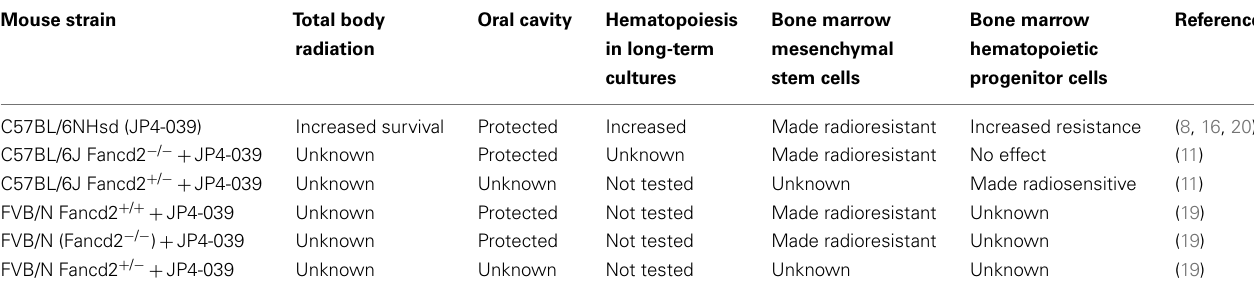
Table 2 | Effect of GS-nitroxide (JP4-039) on radiation biology of Fancd2 − / − mice, tissues, and cell lines